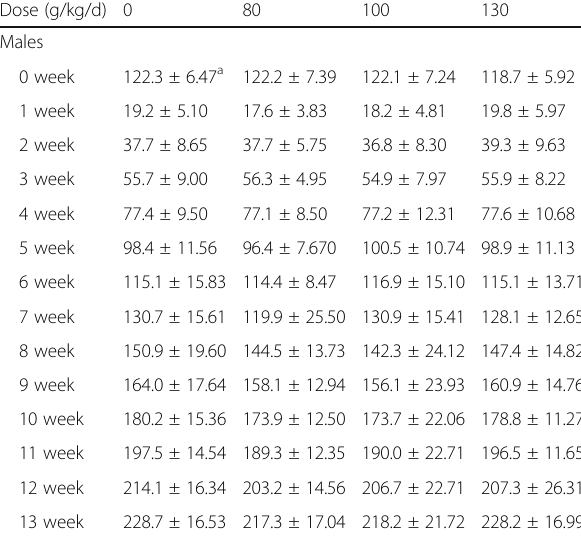
Table 4 Increase in body weight for male rats treated with Table 5 Increase in body weight for female rats treated with